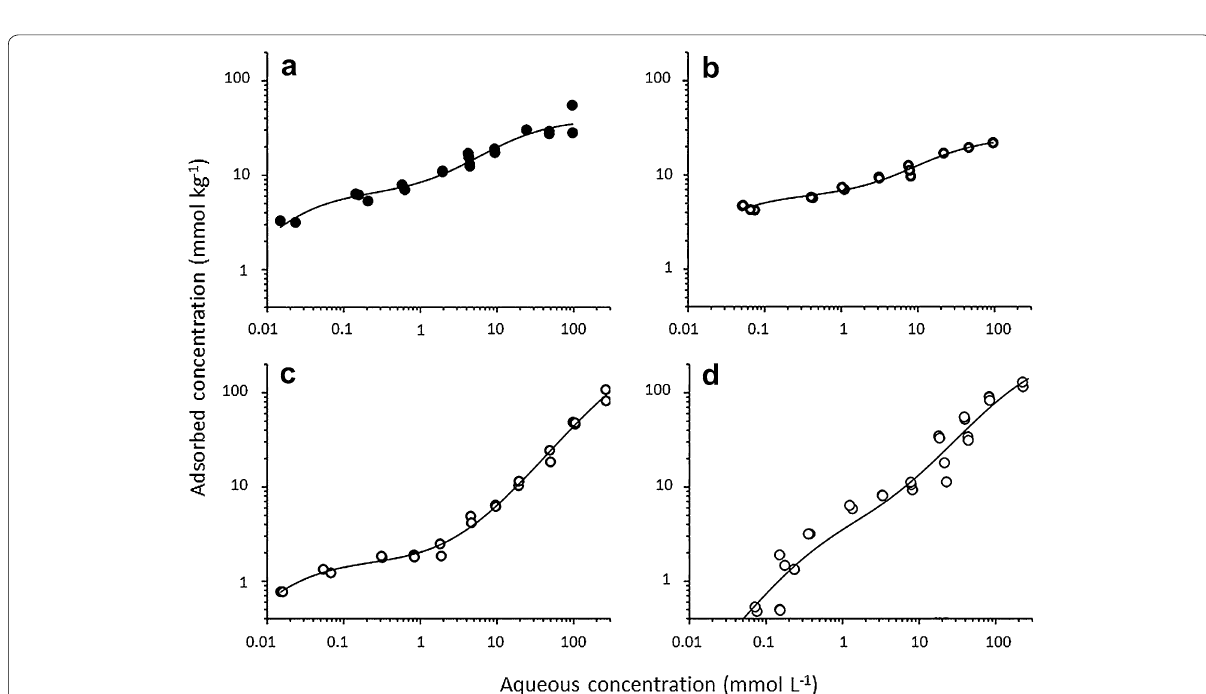
Fig. 2 Sorption isotherms of d -gluconic acid at four pH values ( a pH 4, b pH 7, c pH 9, d pH 12). Isotherms were recorded in 5 mM NaClO 4 solution. Best fits were obtained by the two-site Langmuir isotherm. The data correspond to equilibrium